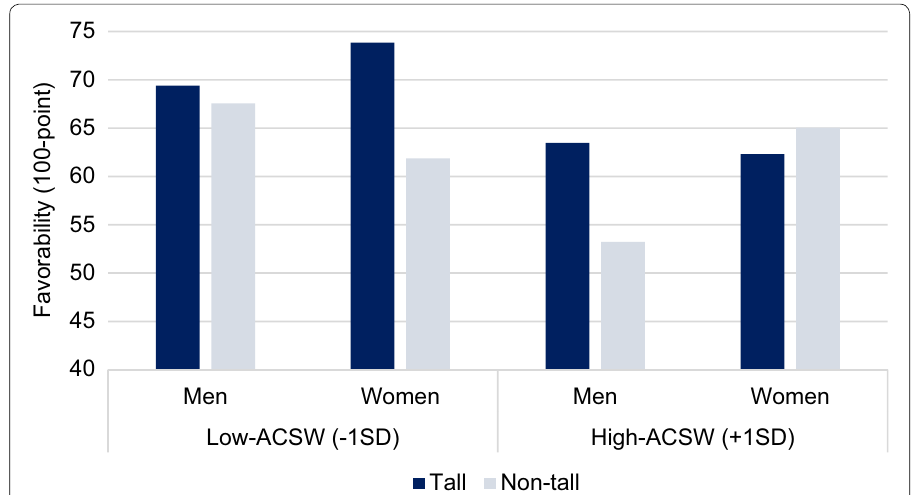
Fig. 1 A 3-way interaction of the target woman’s tallness condition, participants’ gender, and their ACSW value on favorability perception towards the target woman. At the low-ACSW value, women showed higher favorability toward a tall (vs. non-tall) woman while men showed no difference. At the high-ACSW value, men showed higher favorability toward a tall (vs. non-tall) woman while women did not show any